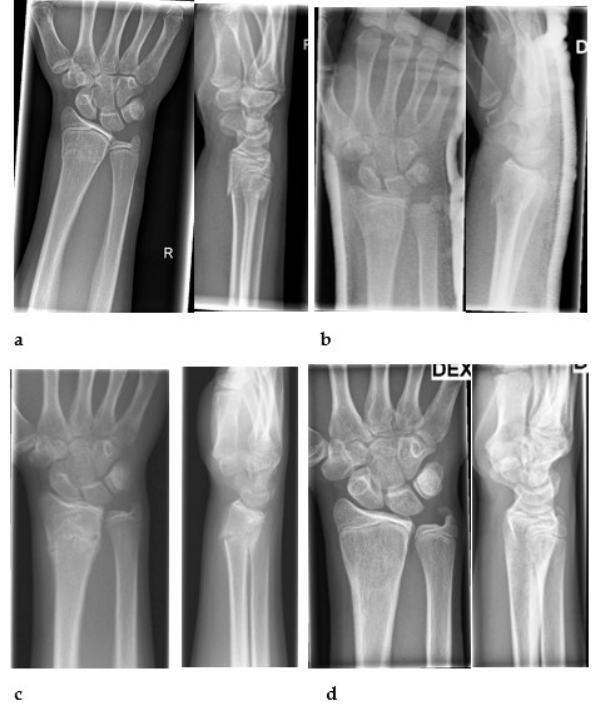
Figure 1. A 14-year-old girl injured her right wrist in downhill skiing. A complete metaphyseal fracture was detected and treated by immobilization without manipulation ( a ). In a follow-up visit at one-week mark, the alignment was good ( b ), but four weeks later a worsening alignment in radius was revealed with 24° dorsal angulation ( c ). A six-month follow-up visit was arranged showing good fracture position ( d ).